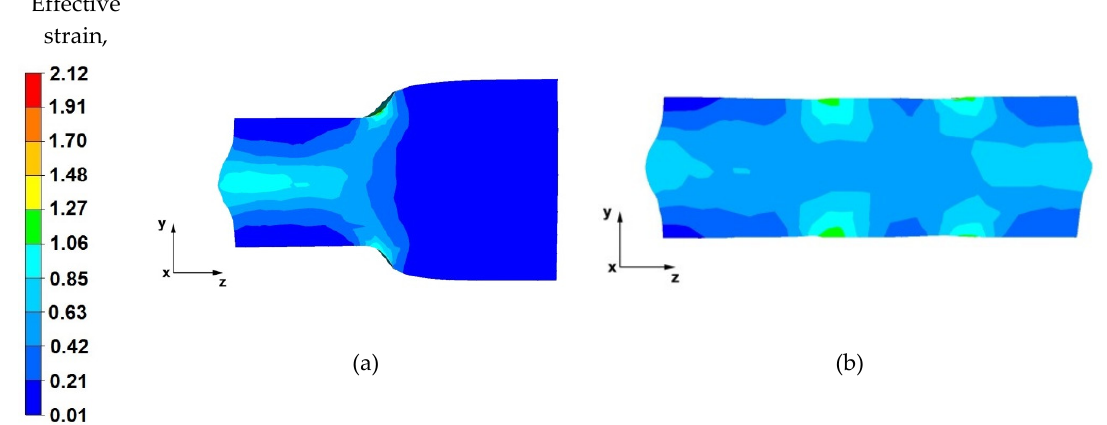
Figure 15. Distribution of the effective strain value on the longitudinal section of the AZ 91 alloy forging with 40% reduction in flat anvils ( a ) forged in the first pass, ( b ) forged in the third pass.